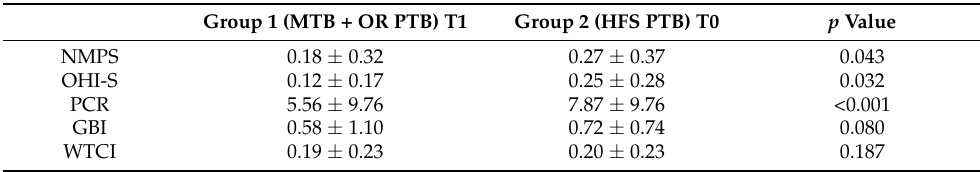
Table 4. Difference in oral hygiene indexes between Group 1 after using the rotating and oscillating powered toothbrush for three months (at T1) and Group 2 at